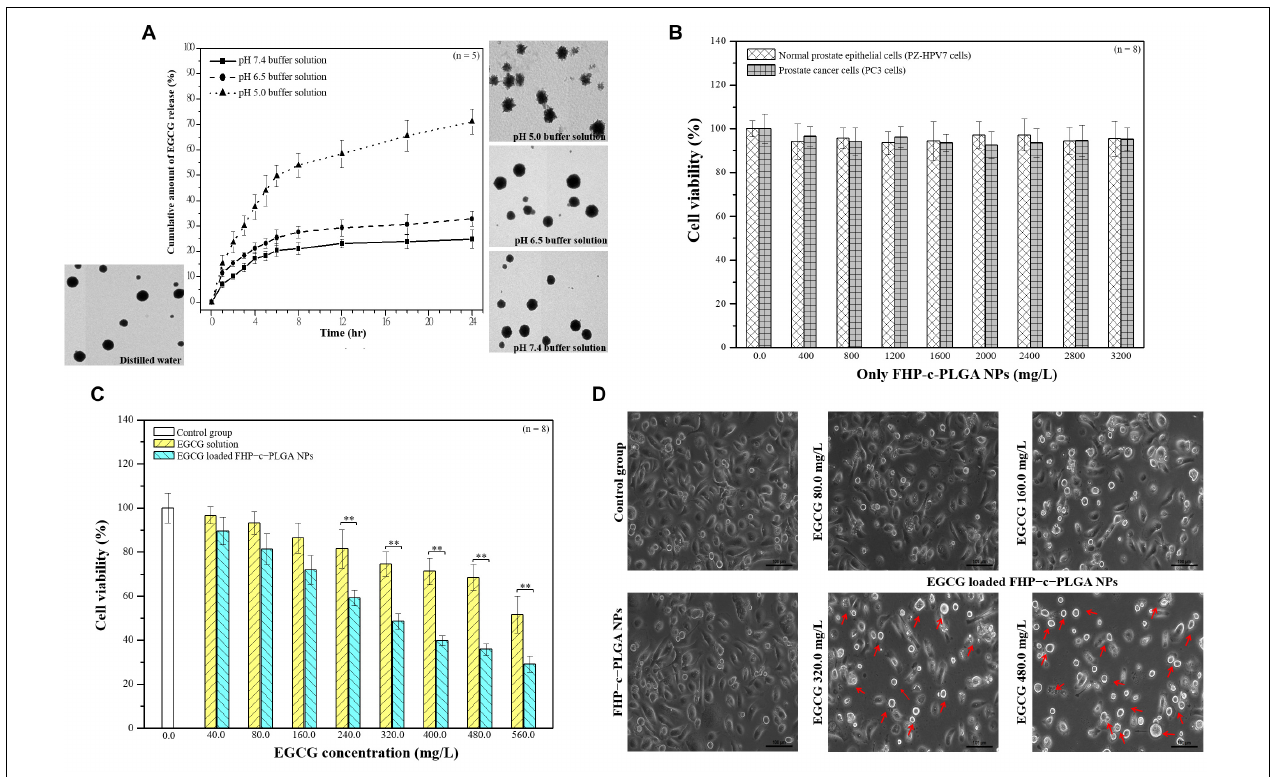
FIGURE 3 | (A) Transmission electron microscopy (TEM) micrographs and in vitro profiles of the release of epigallocatechin gallate (EGCG) from EGCG-loaded FHP–c–PLGA NPs in buffers differing in pH values at 37 ◦ C. (B) Cytocompatibility of normal prostate epithelial cells and prostate cancer cells after treated with different concentrations of only FHP–c–PLGA NPs. (C) Prostate cancer cell viability was determined using 3-(4,5-dimethylthiazol-2-yl)-2,5-diphenyltetrazolium bromide (MTT) assays after cells were treated with EGCG solution or EGCG-loaded FHP–c–PLGA NPs containing different concentrations of EGCG. Asterisk ** represents statistically a significant difference of p value < 0.01. (D) Microscopic observations of cells treated with different concentrations of EGCG in EGCG-loaded FHP–c–PLGA NPs, FHP–c–PLGA NPs, or controls.